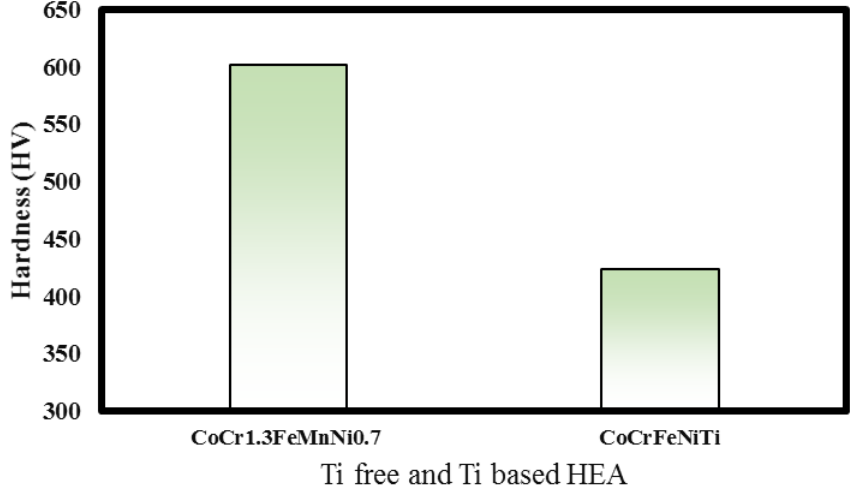
Figure A15. Hardness for best performing Ti-free and Ti based HEA sample.